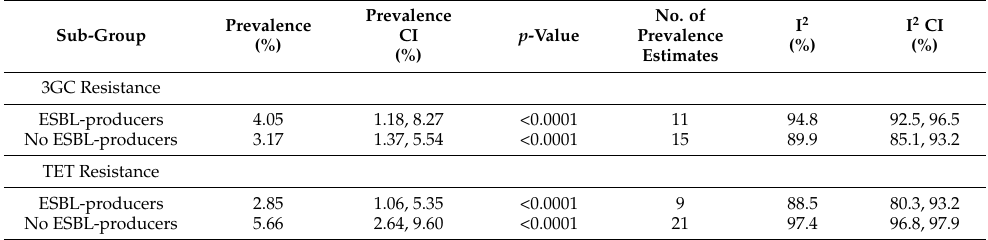
Table A1. Effect of Selection of ESBL-producers on 3GC and TET Resistance